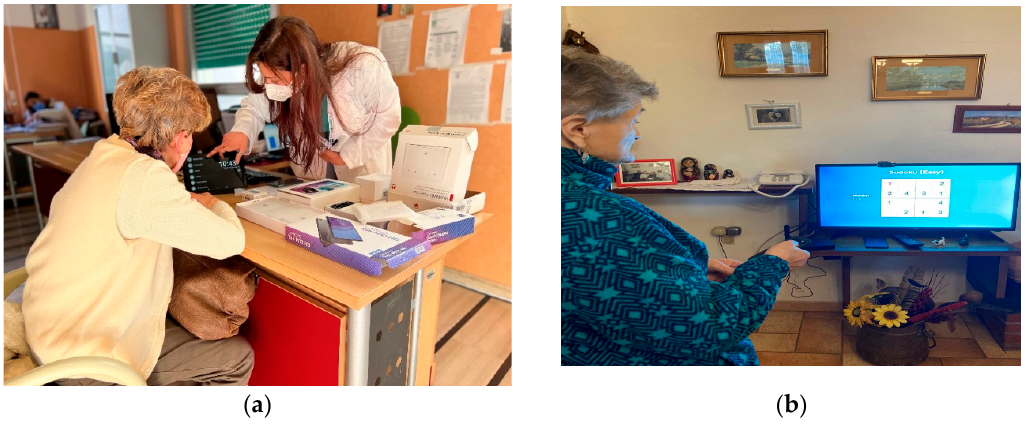
Figure 7. Pre-validation in Phase 2: ( a ) the figure shows how a training session developed during Phase 2 in Apulia. The trainer is showing the SENTAB application on the tablet; ( b ) In this figure, we can see an older adult in Tuscany using a Sudoku puzzle with a 2 × 2 grid (a stimulation exercise tool) on the SENTAB Application. The application is installed on her TV at home.